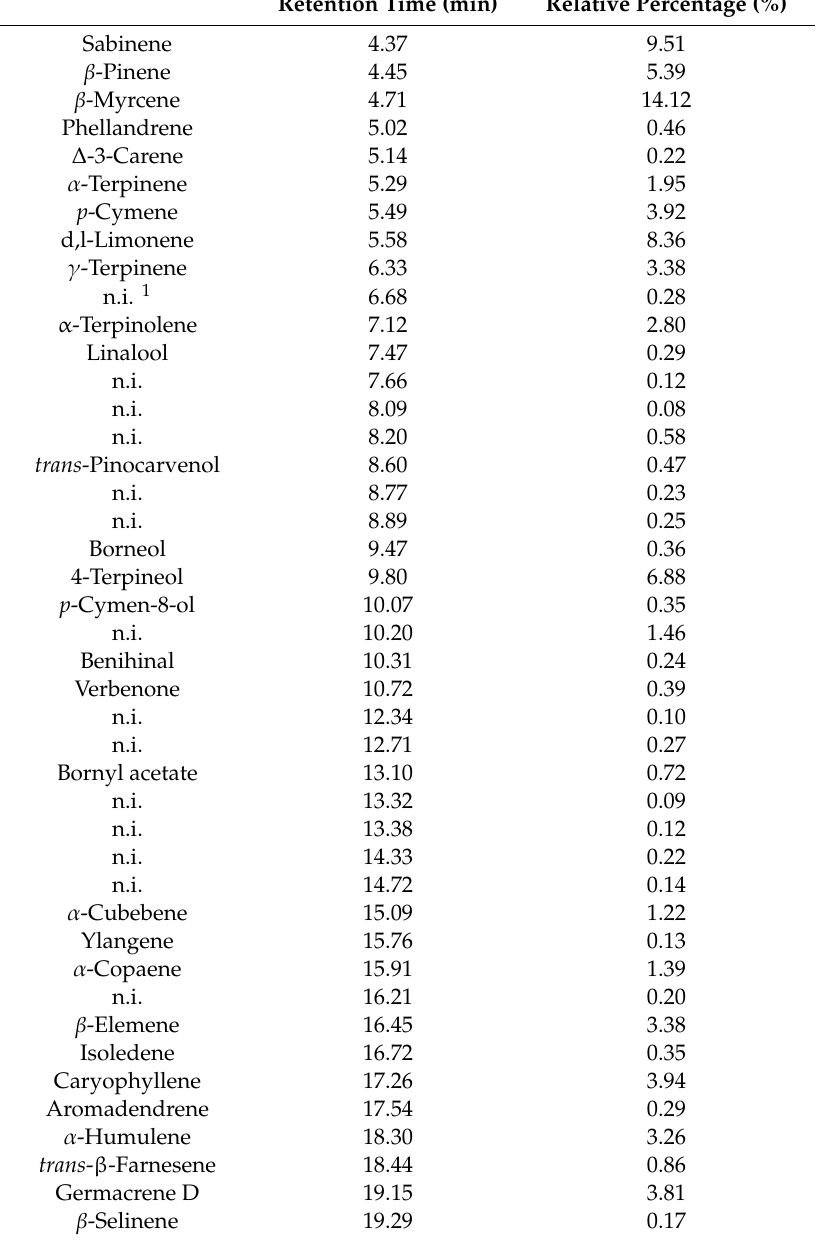
Table 1. Chemical profile of JEO determined by